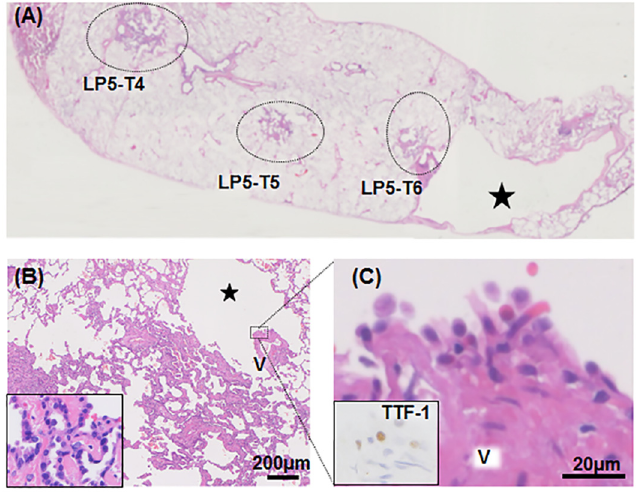
Fig 1. Histological features of atypical adenomatous hyperplasias (AAHs), adenocarcinoma in situ (AIS), and minimally invasive adenocarcinoma (MIA). Hematoxylin and eosin staining of resected lungs. BHD-associated cysts are indicated by stars. (A) Three AAH lesions independently developed in LP5. Each lesion is indicated by a dotted circle. (B) Higher magnification of an AAH lesion in LP5 is shown. This lesion is incorporated into a small cyst. V indicates a blood vessel. The higher magnification of the vein surrounded by a dotted box is shown in (C). Inset: Further magnification of the lesion. (C) Outer surface of the protruding vessel is lined by a layer of pneumocytes with mild atypia. V indicates a blood vessel. Inset: lining cells are immunostained for TTF-1.